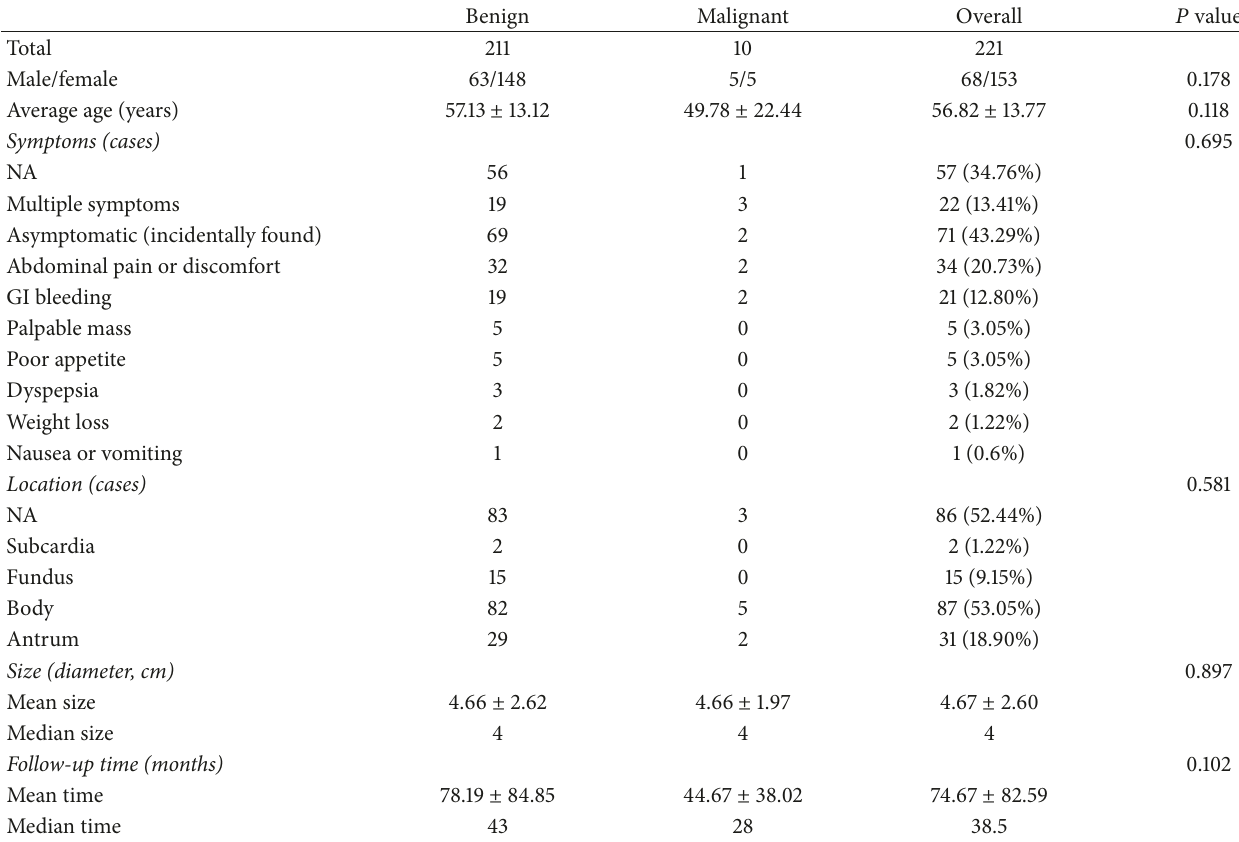
Table 1: Clinical features of GS reported in English